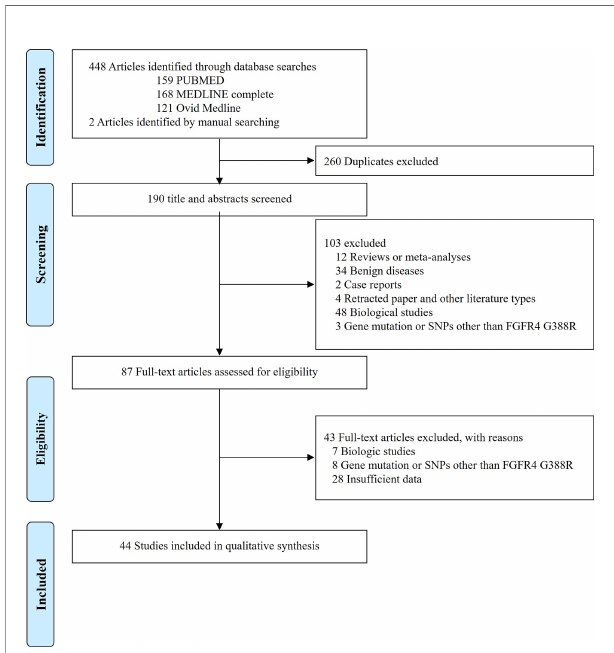
FIGURE 1 | Preferred Reporting Items for Systematic Reviews and Meta- analyses (PRISMA) fl ow diagram showing the selection process of the included